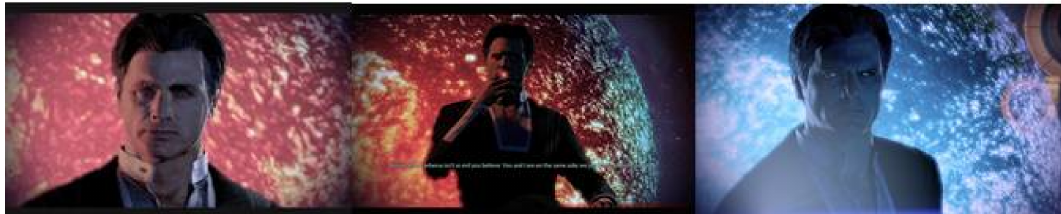
Figure 6. “Illusive